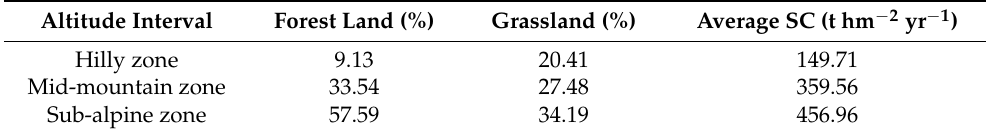
Figure 9. Bar chart of the SC value in the different altitude intervals in 2020. Table 3. Average SC and proportions of forest land and grassland in different altitude zones.